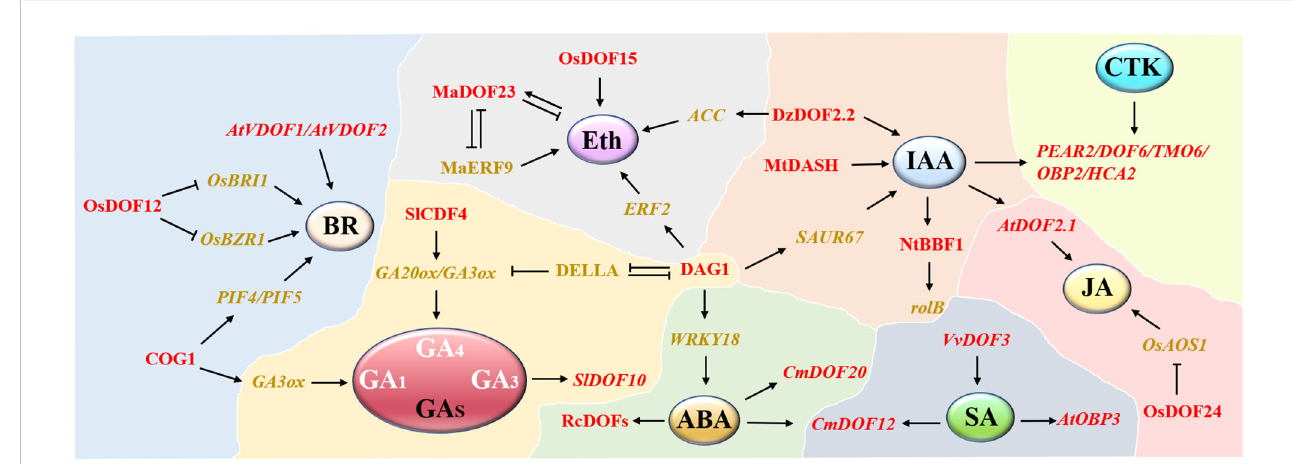
FIGURE 3 A network model of DOF members participating in different phytohormone pathways. A total of 8 hormone modules are distributed. DOF members are shown in red. Positive and negative regulatory relationships are represented by black arrows and blunted lines,